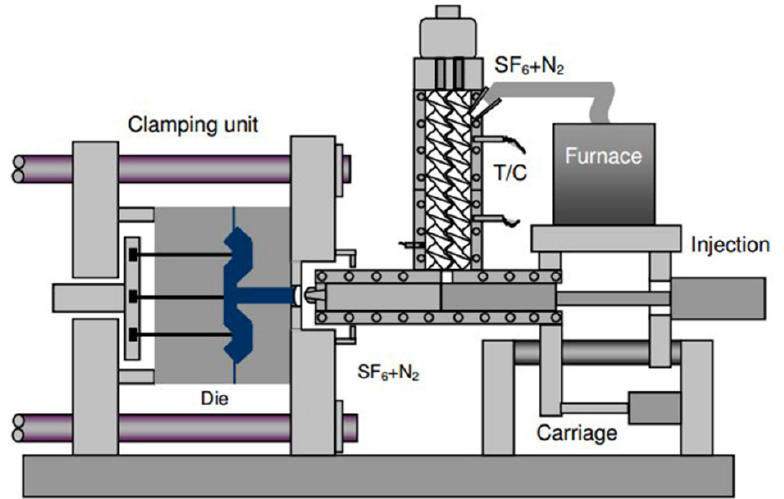
Figure 4. Schematic of rheomoulding process. Reprinted from [29] with permission of Advanced Manufacturing Research Institute, National Institute of Advanced Industrial Science and Technology (AIST).